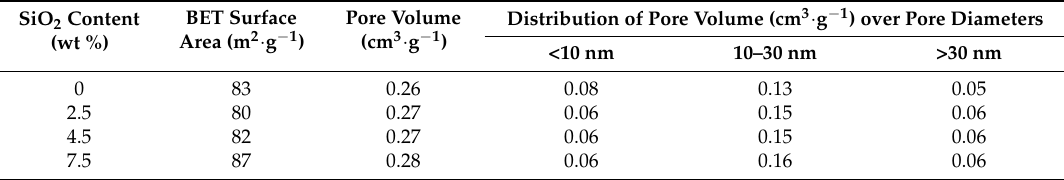
Figure 6. Pore size distribution for initial and SiO 2 ‐ modified supports. Table 2. Porous system parameters of supports.